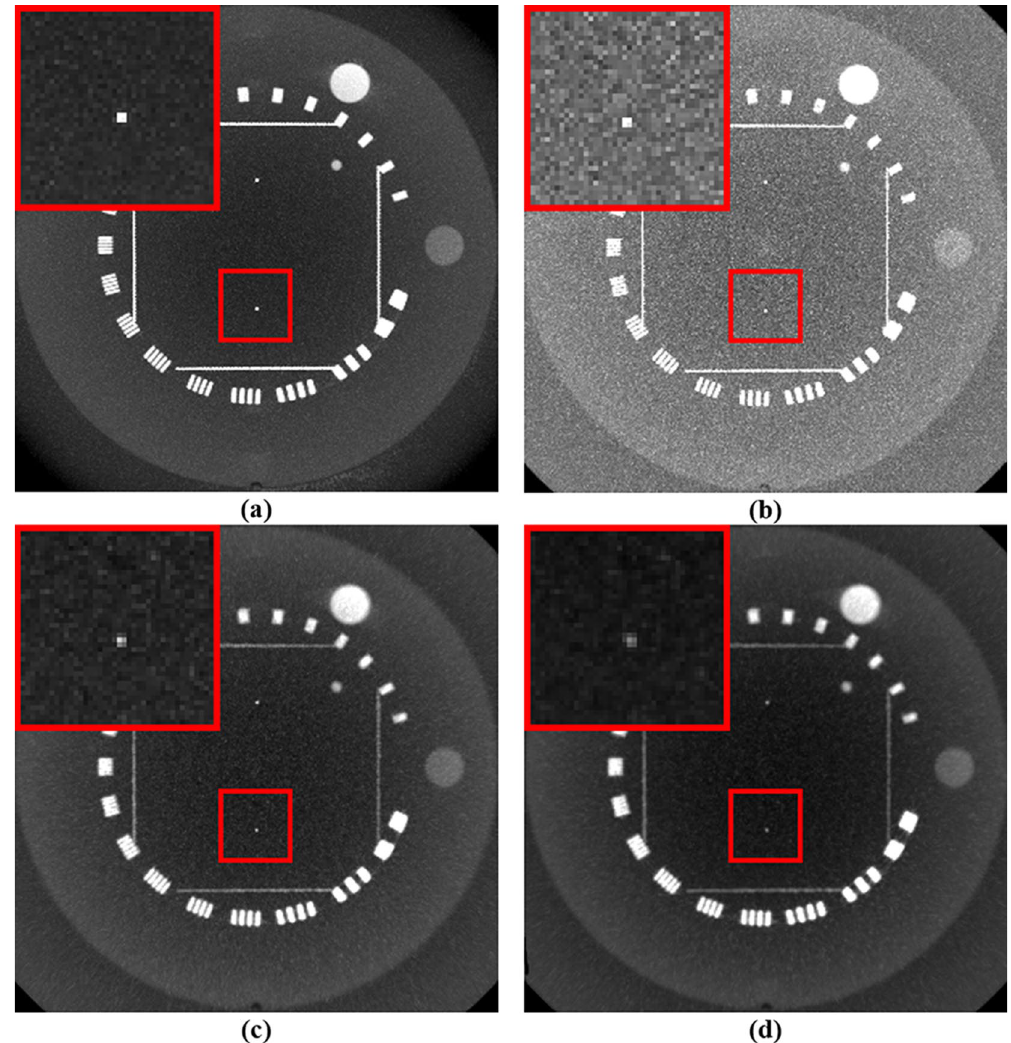
ATV + cubic B-spline, and ( d ) NLTV + cubic B-spline using Catphan503 phantom acquired under a low mAs. These images are displayed at window (width and level) settings of (1100, 500)